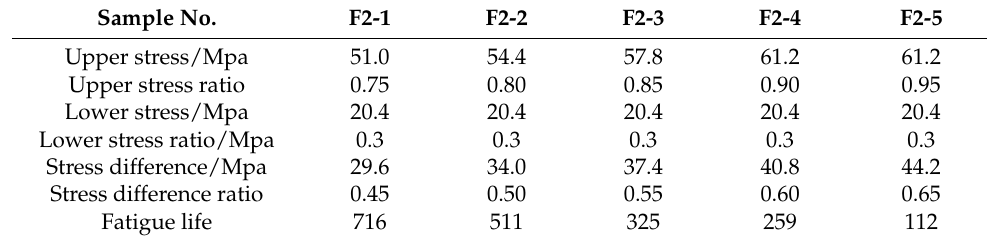
Table 2. The influence of upper limit stress on the fatigue life of yellow sandstone samples. Sample No.